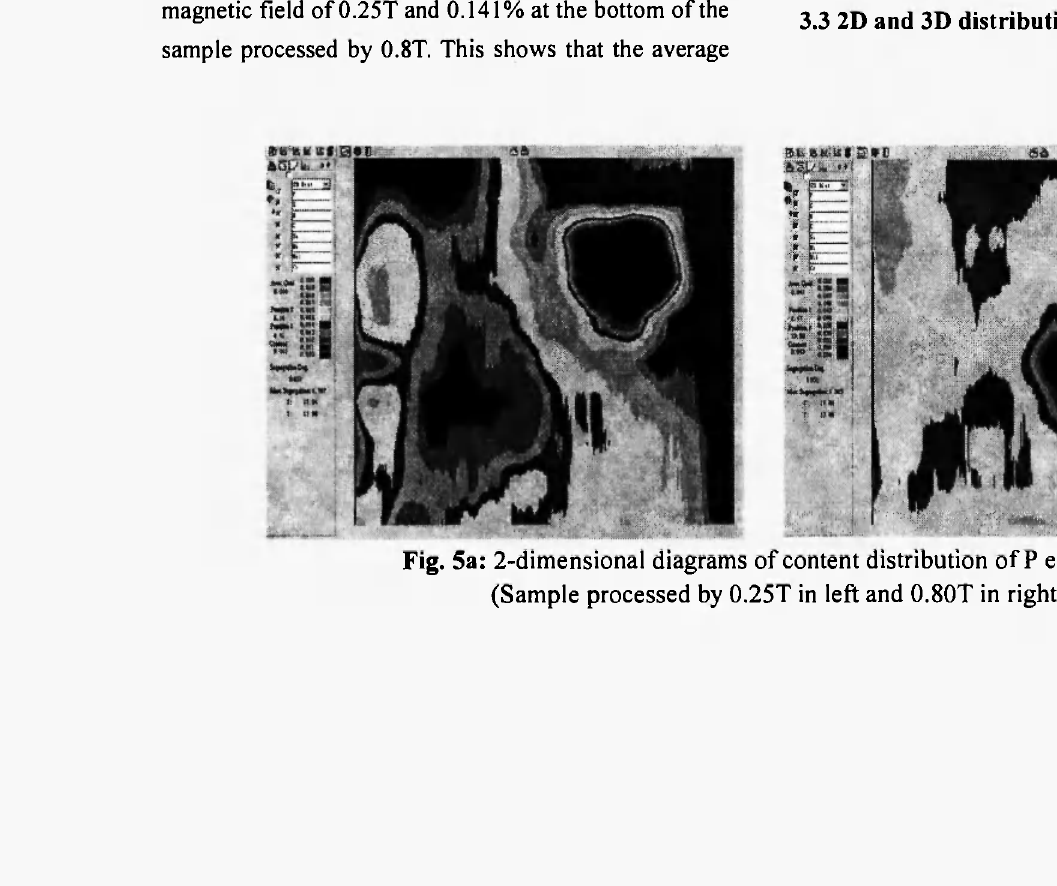
Fig. 4b: 3-dimensional diagrams of content distribution of element C (Sample processed by 0.25T in left and 0.8T in right) amount of element C increases at the bottom region of the sample when the magnetic field intensity increases, but the change tends to increase uniformly, and the amount of increase reduces when the magnetic field intensity increases. Figure 4b shows that, with the increasing of magnetic field intensity, the pinnacle of element C vanishes and negative segregation changes at the bottom of the sample.